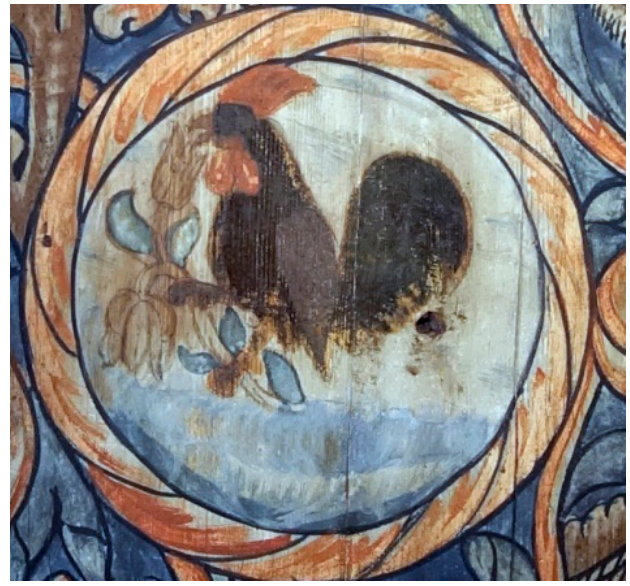
Figure 11. A black rooster, painting on a wooden panel. Unterlimpurg, Synagogue, 1738/9. Schwäbish Hall, Hälisch Fränkisches Museum. Photograph: Zvi Orgad, 2017. Used by permission.